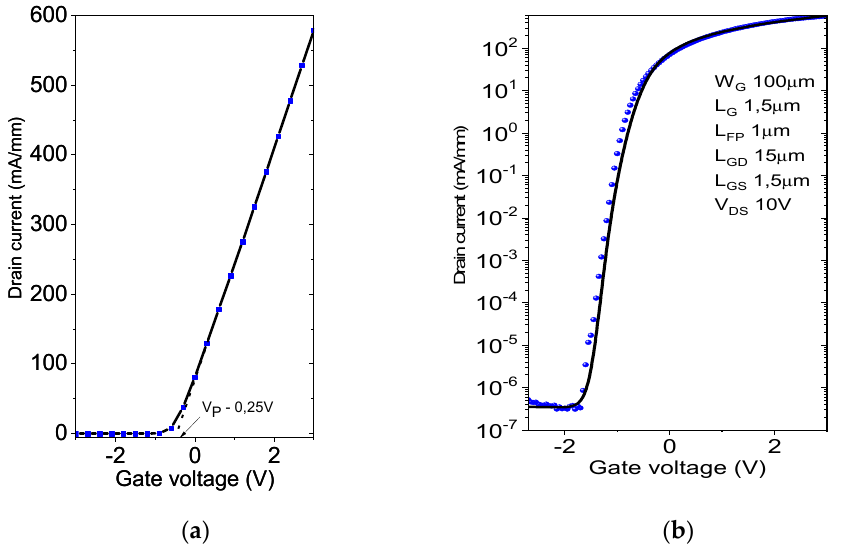
Figure 3. Experimental (doted) and simulated (line) transfer characteristic (I DS -V GS ) of AlGaN/GaN MOS-HEMT device ( a ) in linear and ( b ) logarithm scale.